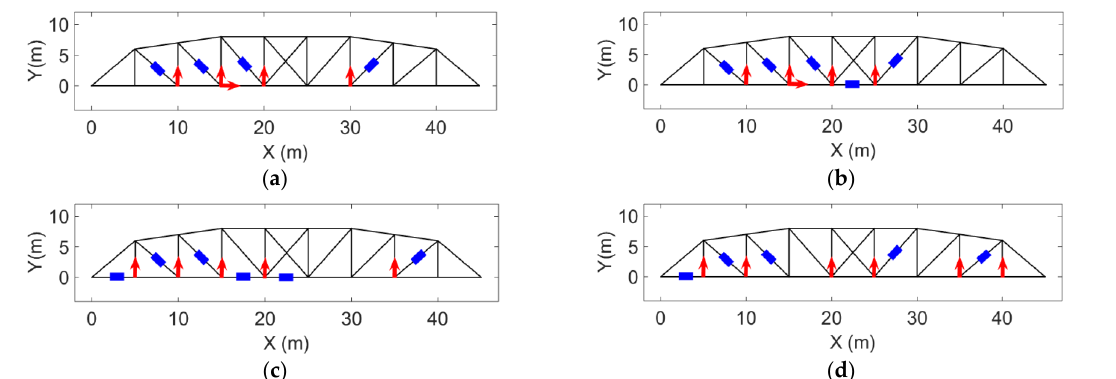
Figure 20. Four different strain and acceleration measurement configurations; Acceleration measurement shown by red arrow and strain measurement shown by blue rectangle. ( a ) Set 1; ( b ) Set 2; ( c ) Set 3; ( d ) Set